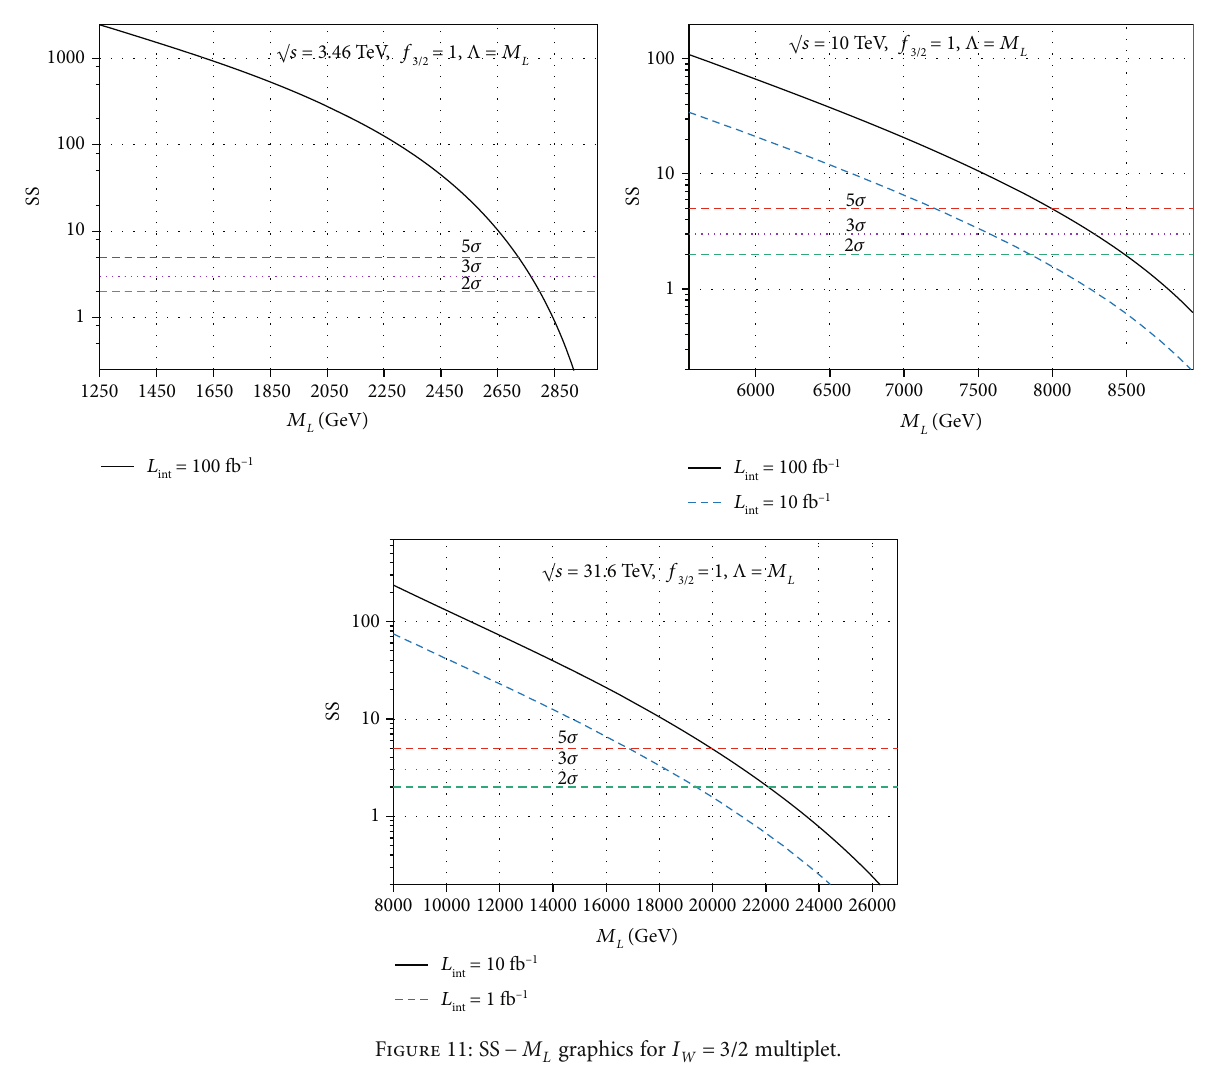
Table 4: Mass limits for the doubly charged leptons for the FCC-based ep colliders taking into account I Collider